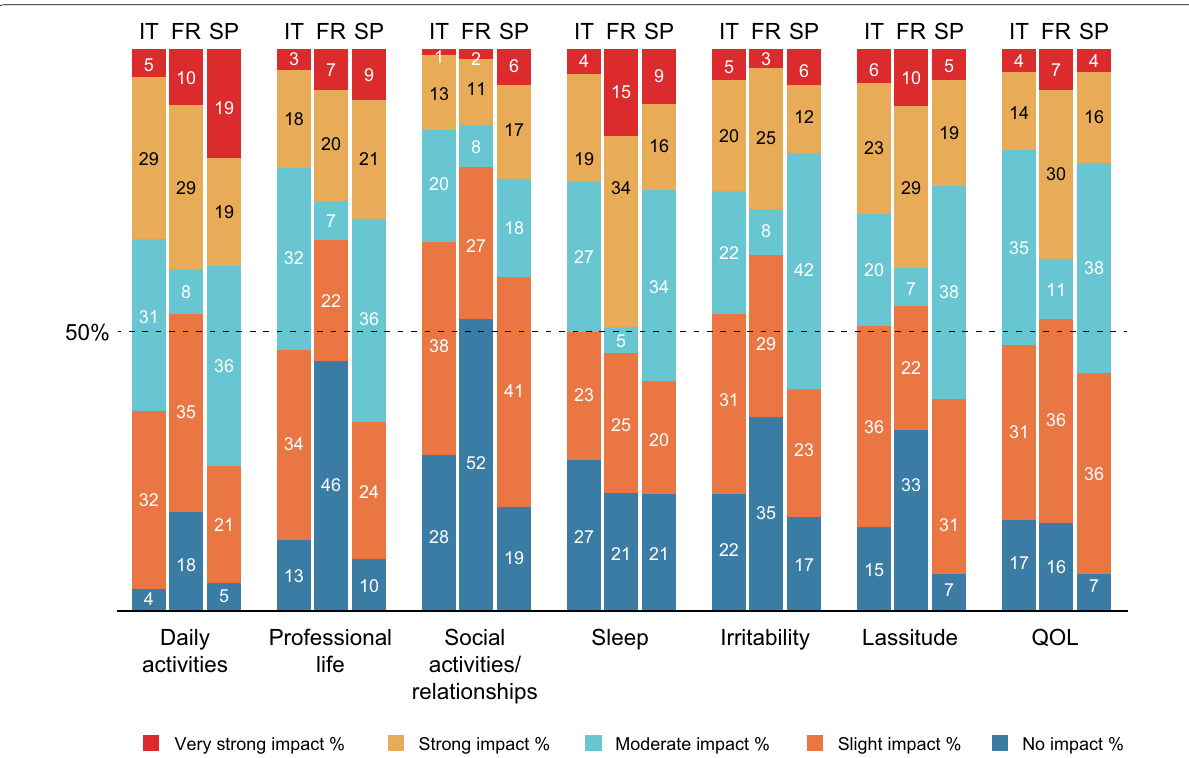
(Fig. 3 for all participants and Additional file 2: Figures S1 and Additional file 3: Figure S2 for ‘HDM-only’ patients).